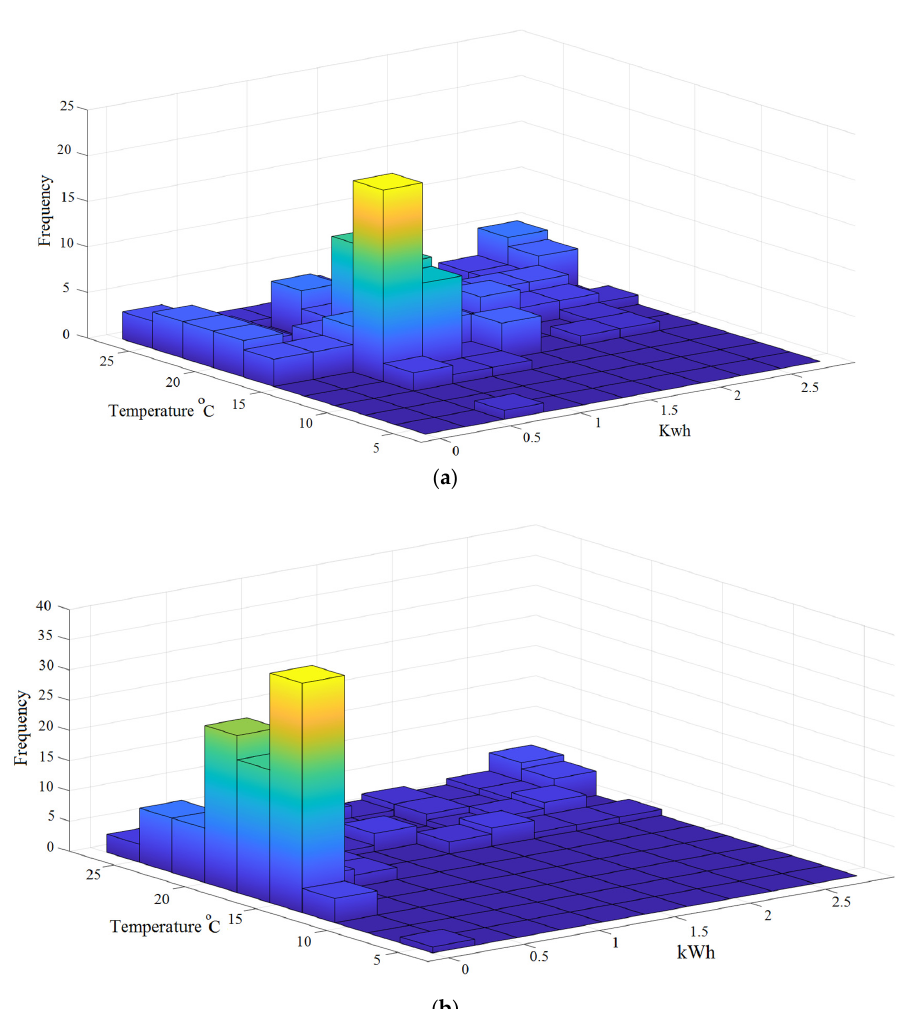
Figure 7. Illustration of distribution of: ( a ) household demand and temperature ( b ) PV system output and temperature in a 2D histogram.